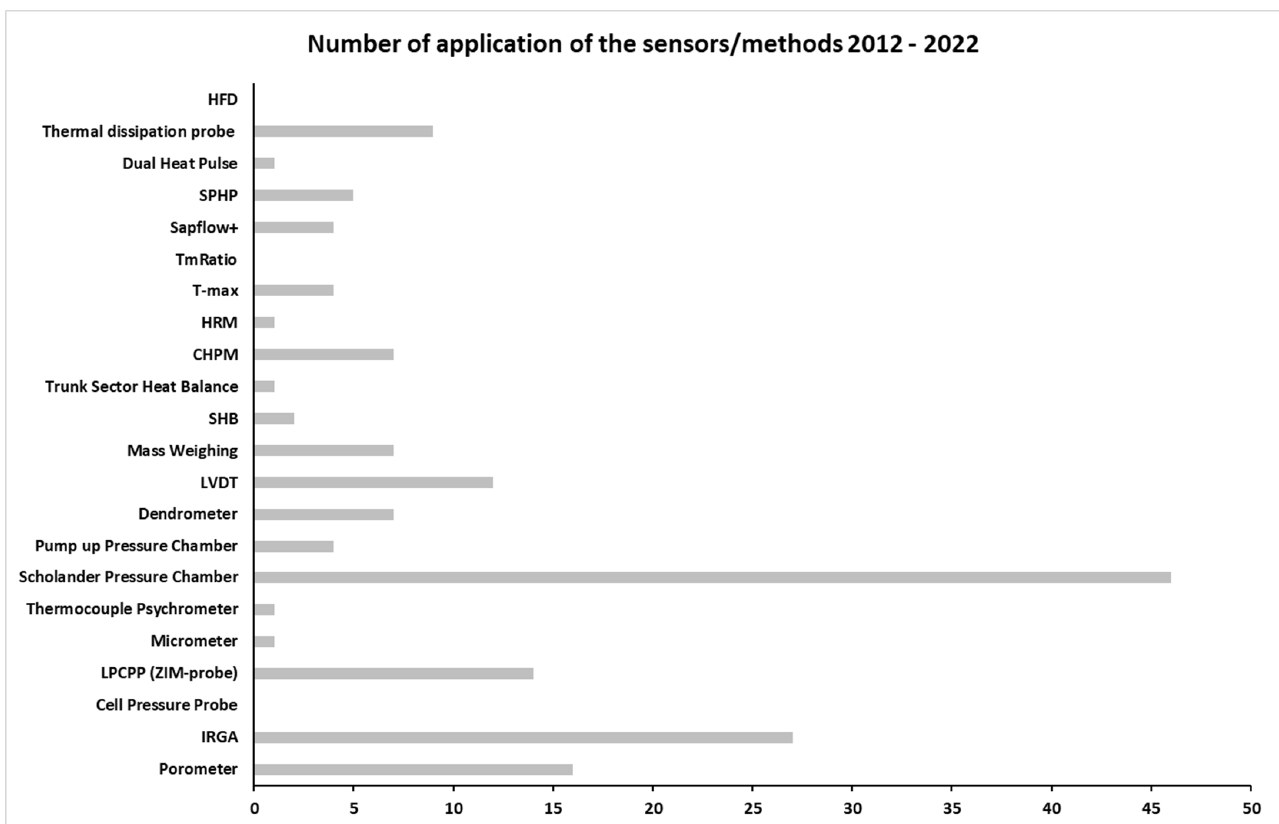
Figure 2. Number of applications of the different sensors and methodologies from 2012 till 2022 for Mediterranean fruit and nut tree crops.